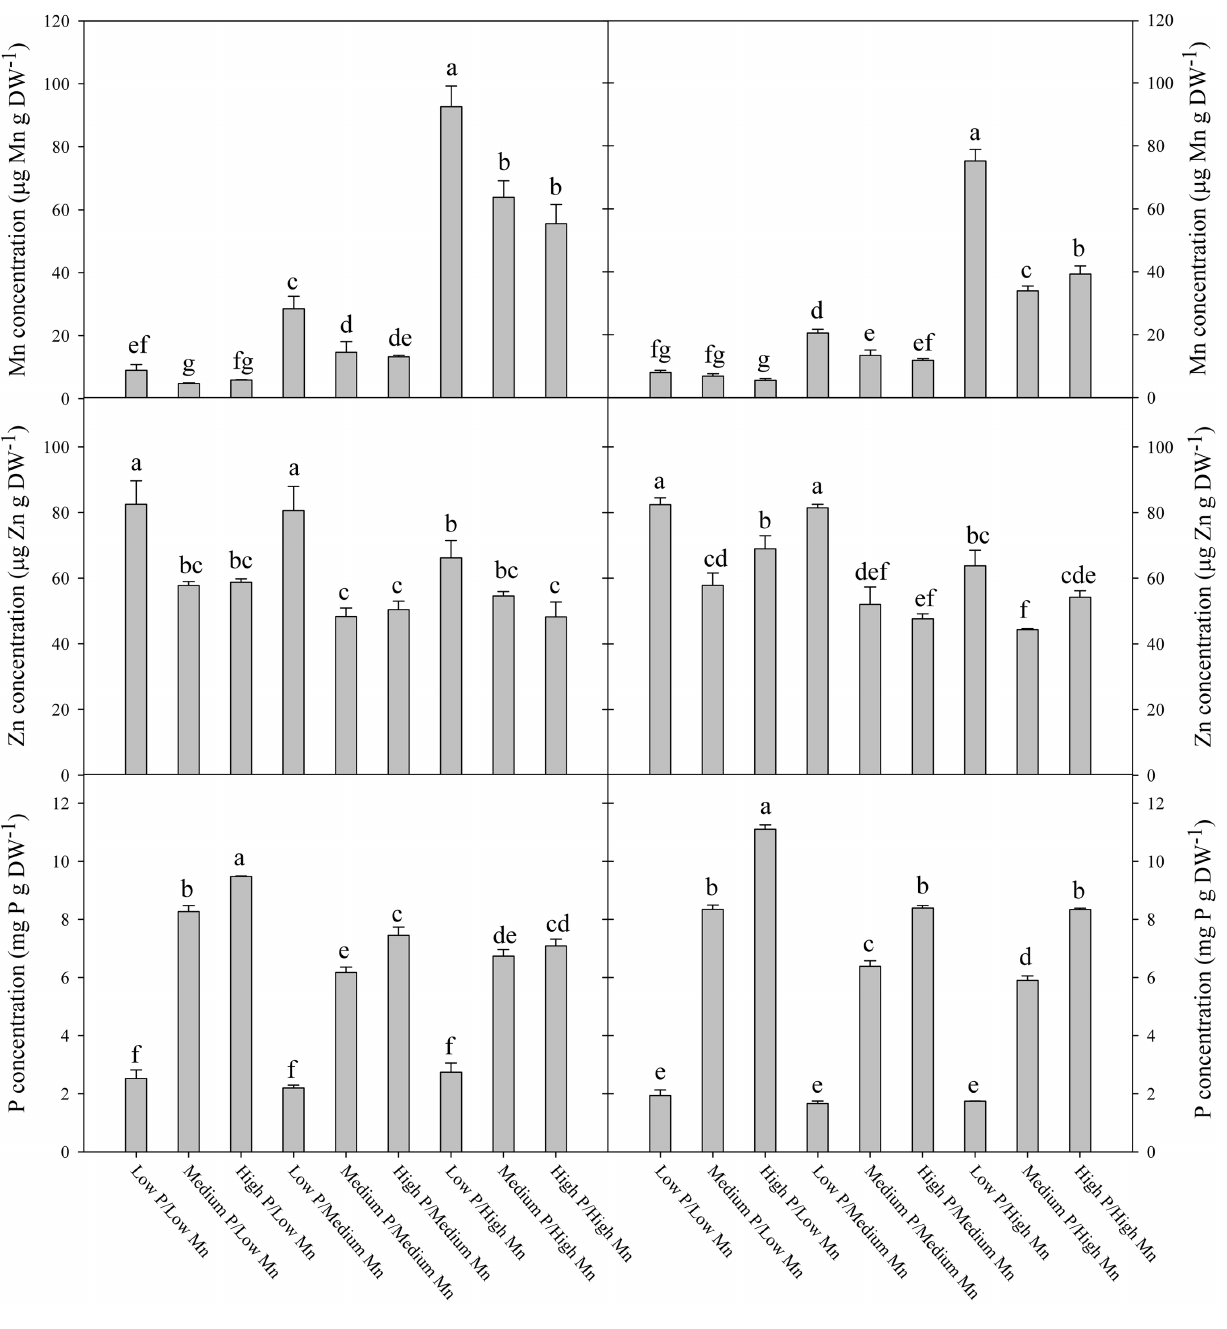
FIgure 6 | The concentration of Mn (A,D), Zn (B,e), and P (C,F) in the youngest fully emerged leaf of the Mn-inefficient genotype Antonia (A–C) and Mn-efficient genotype Vanessa (D–F) growing in hydroponics at different Mn and P levels. Values are means ± SE ( n = 3); same letter above columns denote no significant differences between treatments ( p >